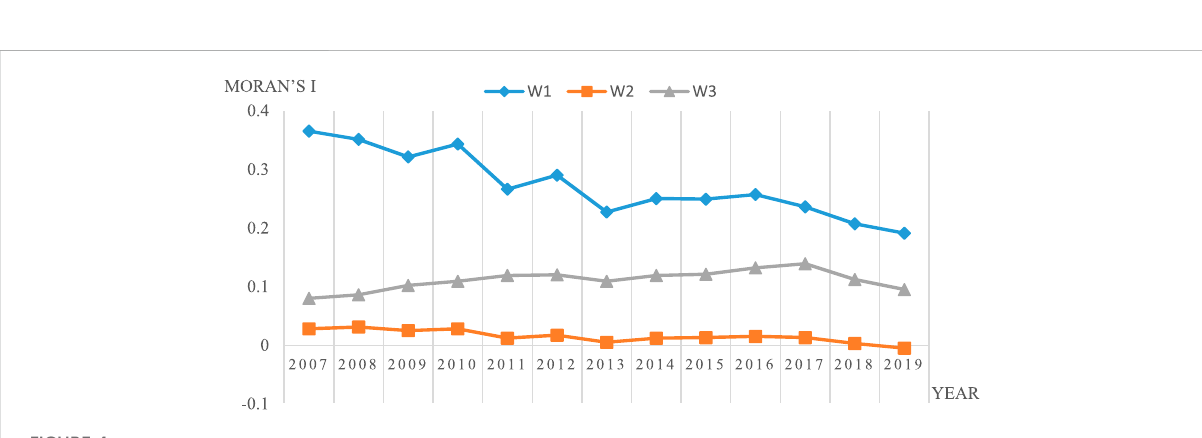
FIGURE 4 p -value of Moran ’ s I of carbon productivity in China under three spatial weight matrices from 2007 to